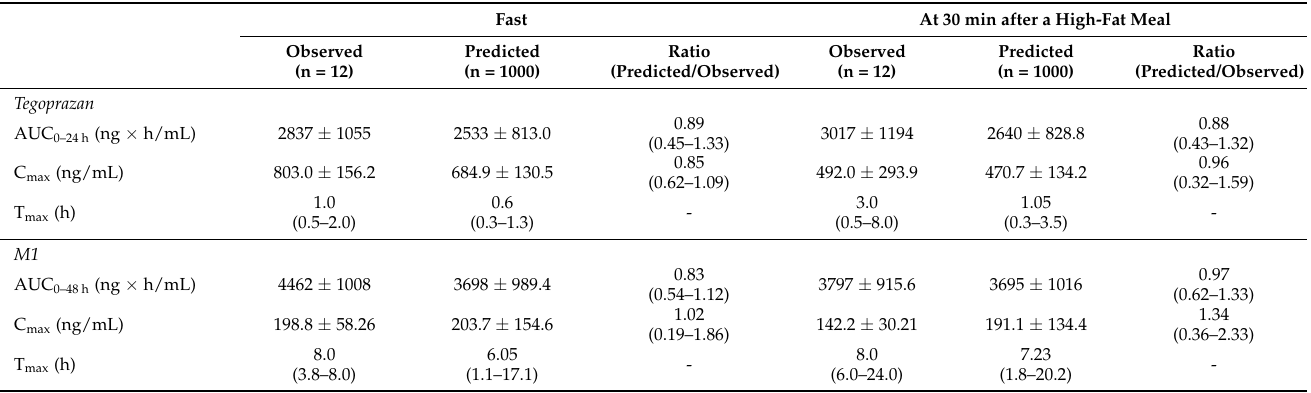
Table 5. The predicted and observed AUC last , C max , and T max for tegoprazan and M1 after a single administration of 50 mg tegoprazan in the fasted state or at 30 min after a high-fat